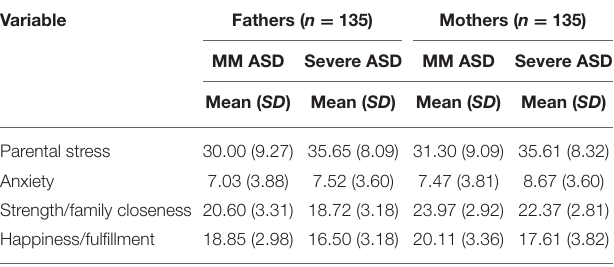
TABLE 5 | Pearson correlations between mothers’ and fathers’ scores for studied variables.